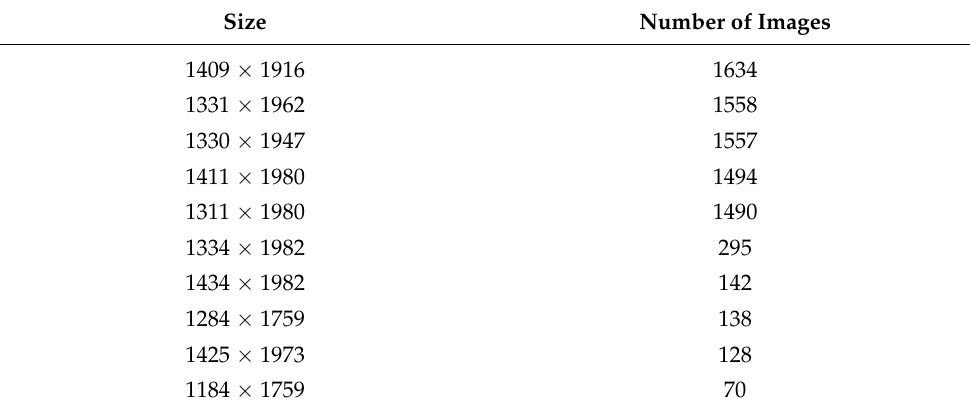
Table 4. Image size in the Stanford dataset.